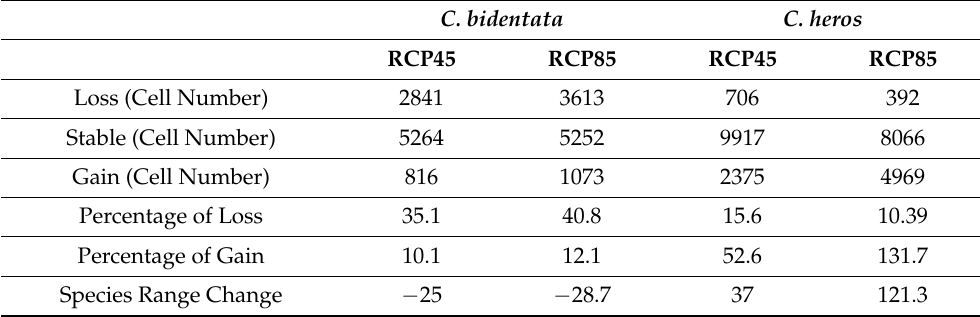
Table 2. The changes in the size of suitable area in the number of pixels for the future